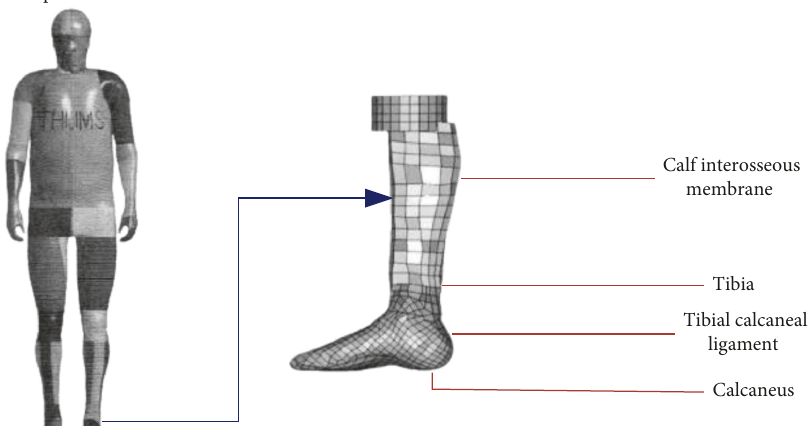
Figure 1: Simulated ankle injury.